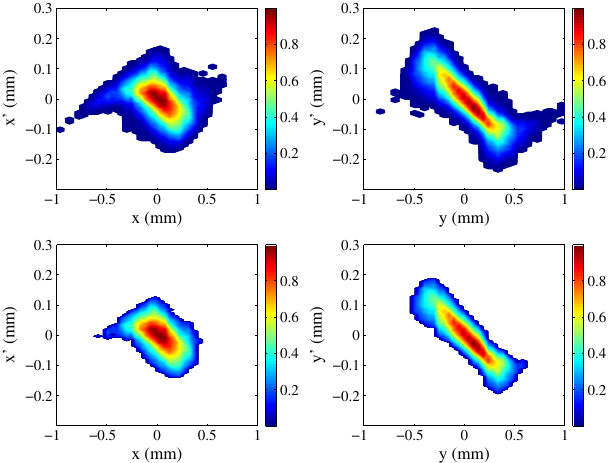
FIG. 26. Measured horizontal (left column) and vertical (right column) phase space for a bunch charge of 1 nC. The upper row corresponds to the raw data (100% of the measured beam signal), whereas the bottom plots are obtained for 90% of measured charge.